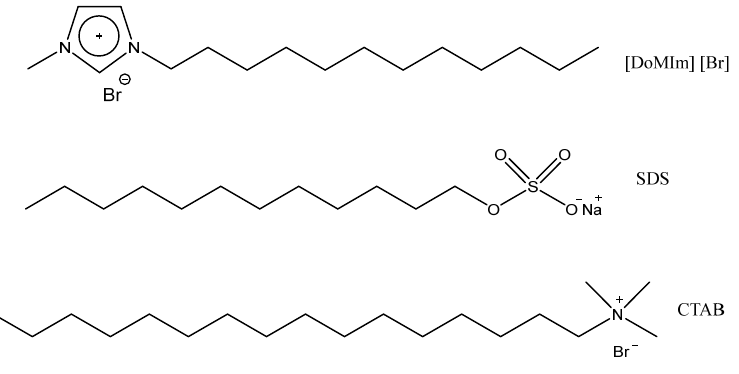
Figure 1. Micelle forming surfactants used. Table 1. Comparison of DA reaction in different aqueous micellar media. Reaction Media